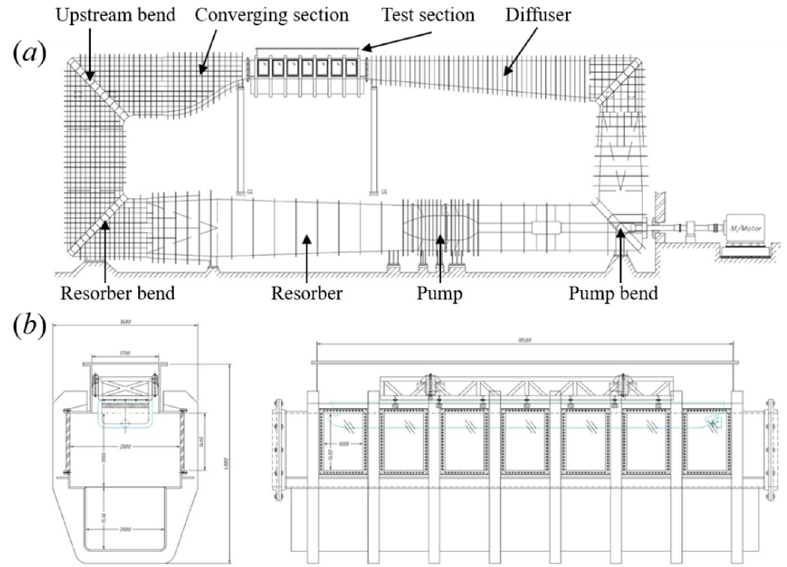
Figure 8. Schematic of the large cavitation tunnel at Korea Research Institute of Ships and Ocean Engineering: ( a ) entire structure of the tunnel; ( b ) test section.